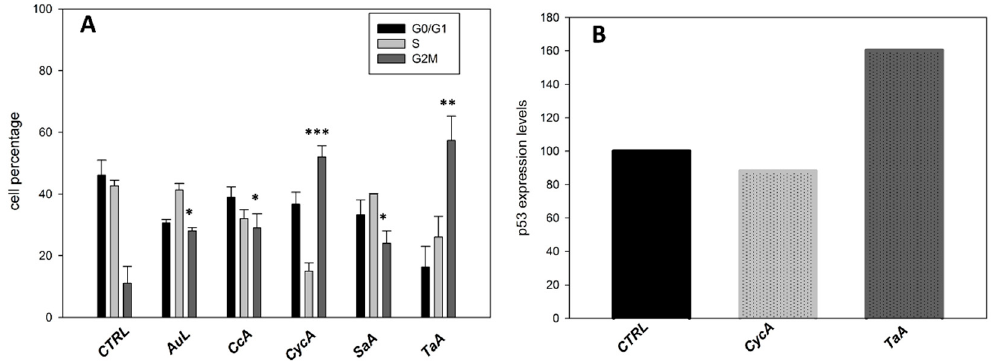
Figure 2. E ff ects of most potent plant extracts on cell cycle progression and p53 levels. ( A ) Cell cycle distribution of U2OS after 48 h of treatment with the plant extracts. Data are presented as means ± SD of three di ff erent experiments. Di ff erences were considered significant when p ≤ 0.05 (* p ≤ 0.05; ** p ≤ 0.05; *** p ≤ 0.001). ( B ) Flow cytometric analysis of p53 protein levels after CycA or TaA treatment. The histograms represent the protein expression levels with respect to the control taken arbitrarily as 100%. Results shown are representative data from three similar experiments.